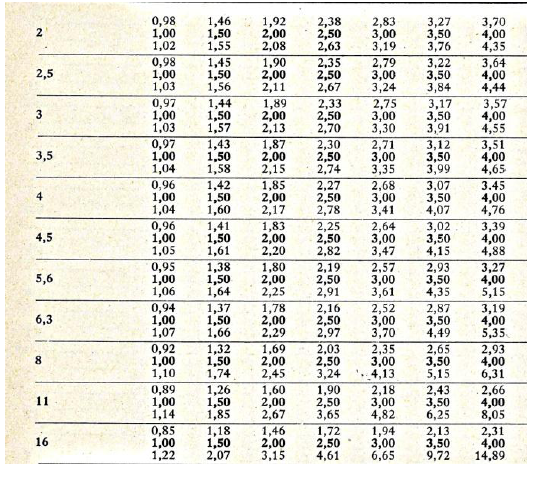
Figure 1. Field depth (cm)